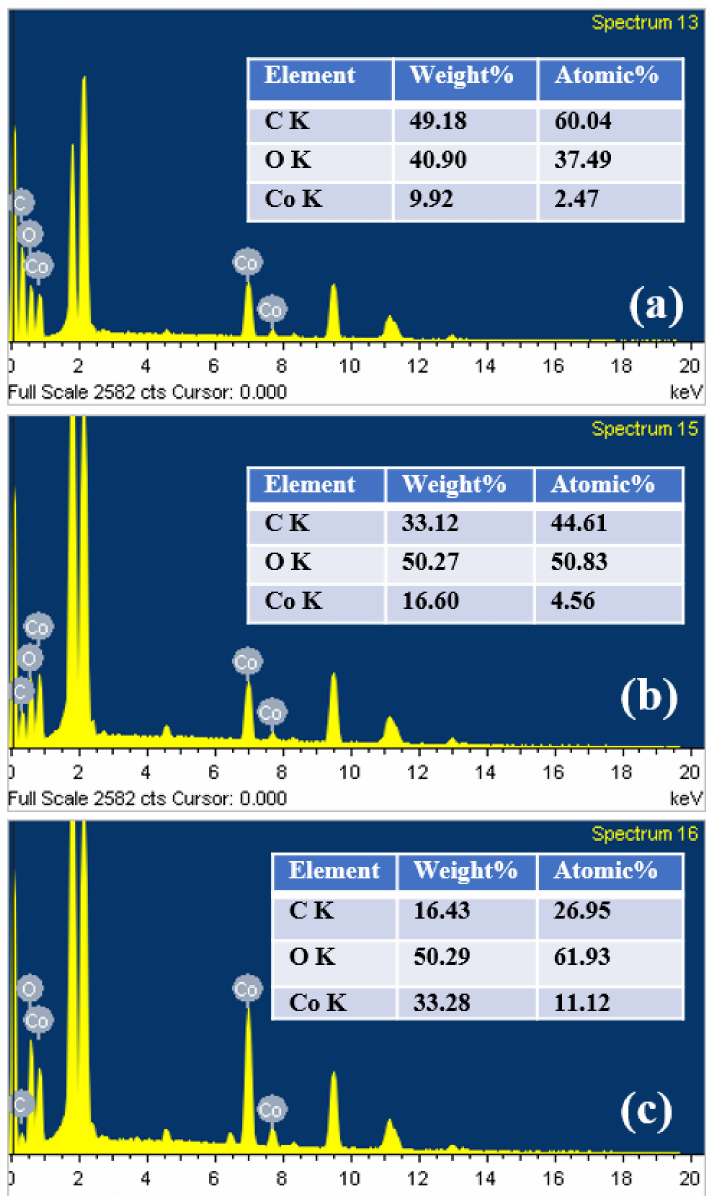
Figure 4. EDX spectra of the electrodes cured with ( a ) 2 pulses, ( b ) 25 pulses and ( c ) 100 pulses,